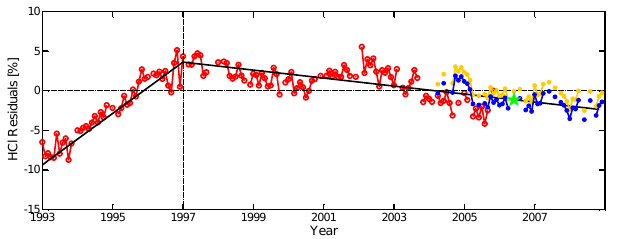
Fig. 3. HALOE (red line circle) and ACE-FTS anomalies (orange dot line) for 30 ◦ S–50 ◦ S, 35–45km after seasonal and QBO terms are removed. ACE-FTS anomalies are shifted so that they align with the HALOE values (blue dot line). The solid black line indicates the fit line of HALOE extrapolated beyond 2005. The dashed line indicates the turn around year for HALOE HCl values (1997). The green star indicates the mean value along the HALOE fit line during the overlapping period with ACE-FTS. The value at the star is the offset value, which is applied to the ACE-FTS anomalies so that they shift relative to the HALOE anomalies for the overlapping time